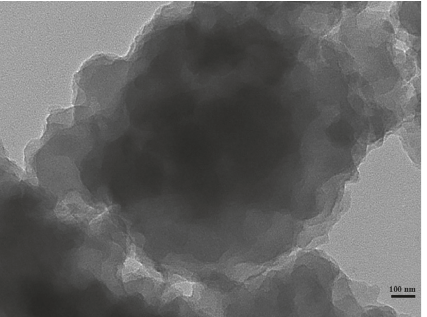
Figure 5: The transmission electron microscope image of MIPs.